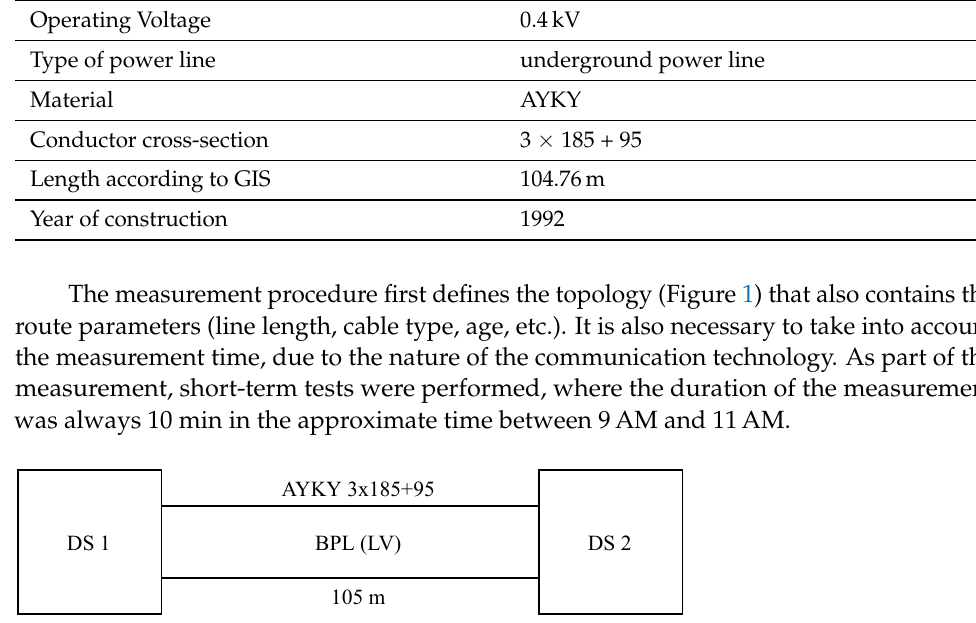
Figure 1. Diagram of measured